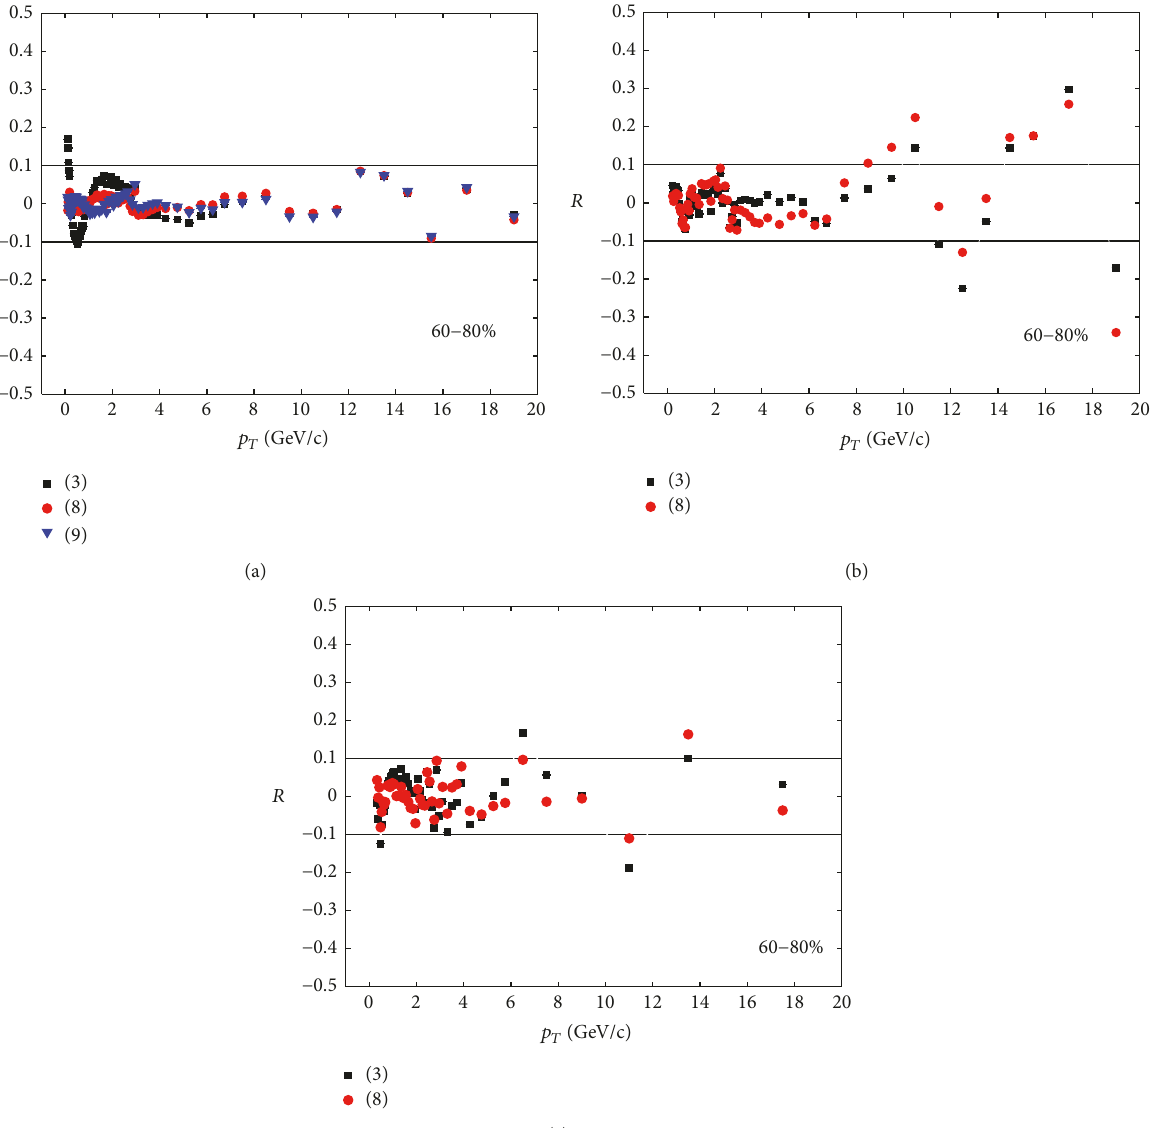
Figure 5: The relative discrepancies of (3), (8), and (9) from the 𝑝 𝑇 spectra for (a) 𝜋 + + 𝜋 − , (b) 𝐾 + + 𝐾 − , and (c) 𝑝 + 𝑝 at centrality 60–80% shown in Figures 1, 2, and 3,